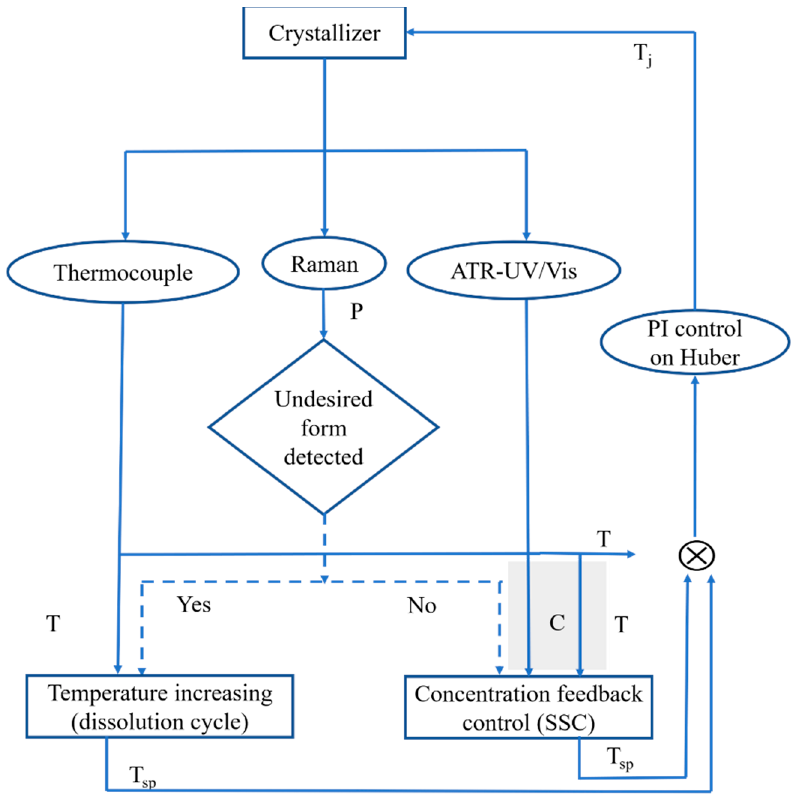
Figure 9. Schematic of the active polymorphic feedback control (APFC) approach for polymorphic control.